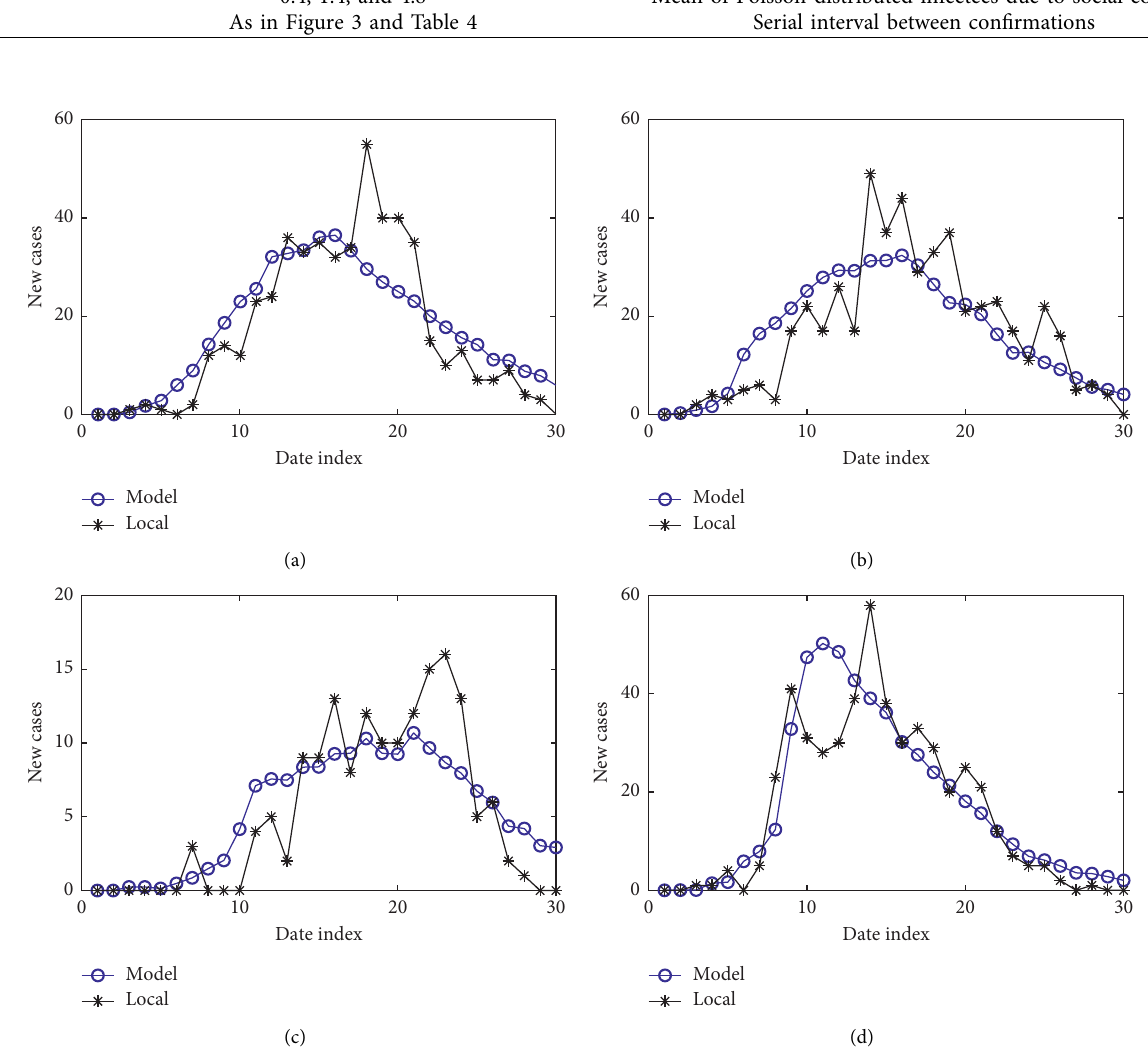
Figure 4: The simulating results and the real time series. The parameters for the best fit of the local series in each province are provided on top of each figure. The blue curves are obtained from our model with the average of 50 trials. The black curves are the original time series. (a) Anhui ( α � 0.8 and λ � 0.4). (b) Henan ( α � 0.1 and λ � 1.0). (c) Jiangsu ( α � 0.7 and λ � 0.2). (d) Zhejiang ( α � 0.1 and λ �